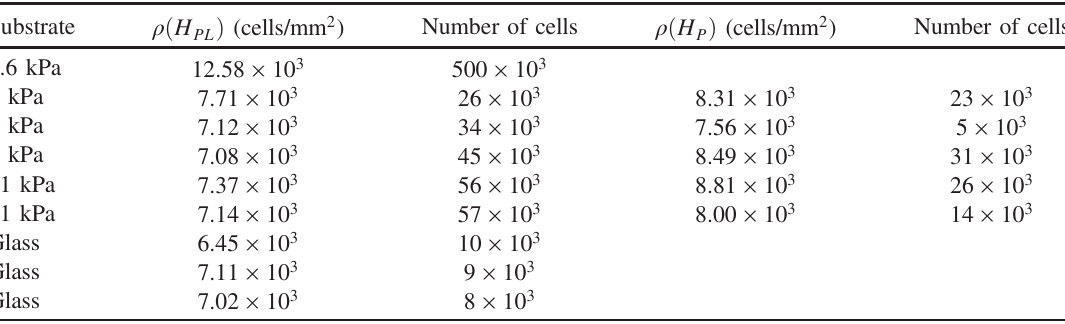
TABLE I. Information about the amount of cells considered in obtaining the density of the homeostatic states. Substrate